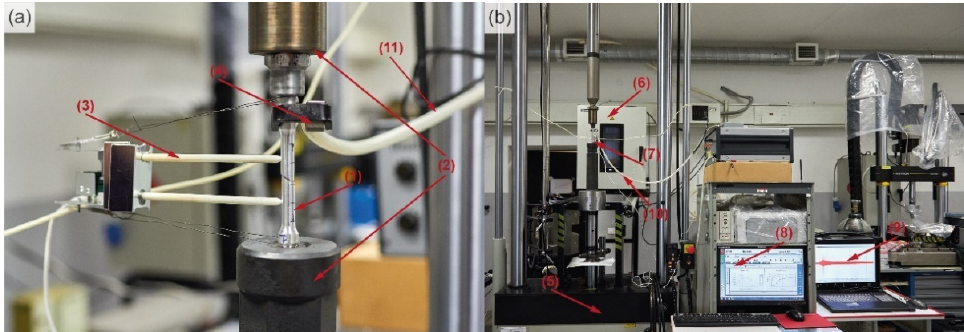
Figure 3. Experimental setup: ( a ) magnified view of the specimen and ( b ) general view of the testing facilities; (1)—specimen; (2)—high-temperature grips; (3)—extensometer with ceramics probes; (4)—AE sensor; (5)—Instron 8802 servohydraulic frame; (6)—environmental chamber; (7)—thermocouple; (8)—test-controlling PC; (9)—AE system; (10)—AE sensor clamp; (11)—air-chilled thermal insulating shell for the AE signal cable.